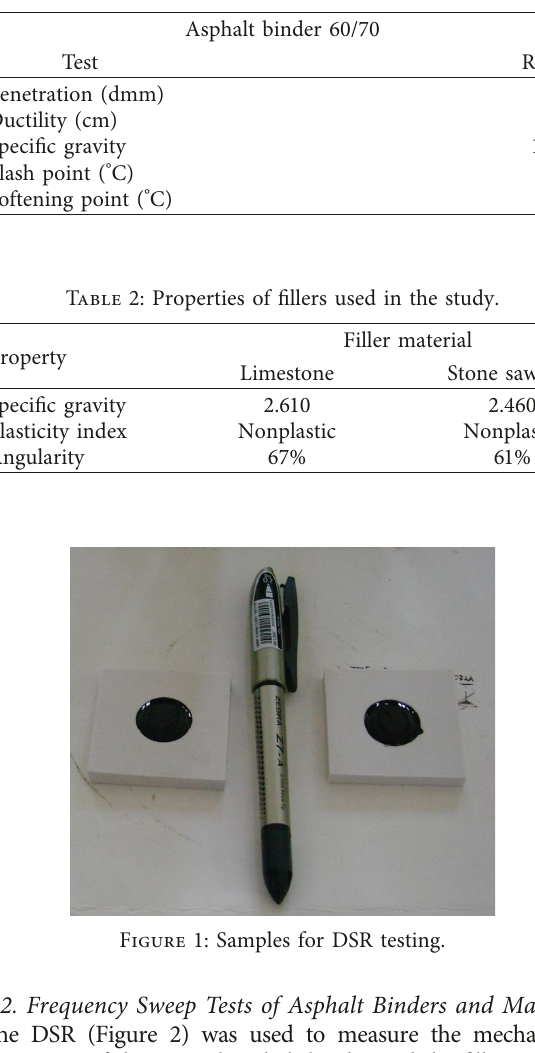
Table 1: Original asphalt binder